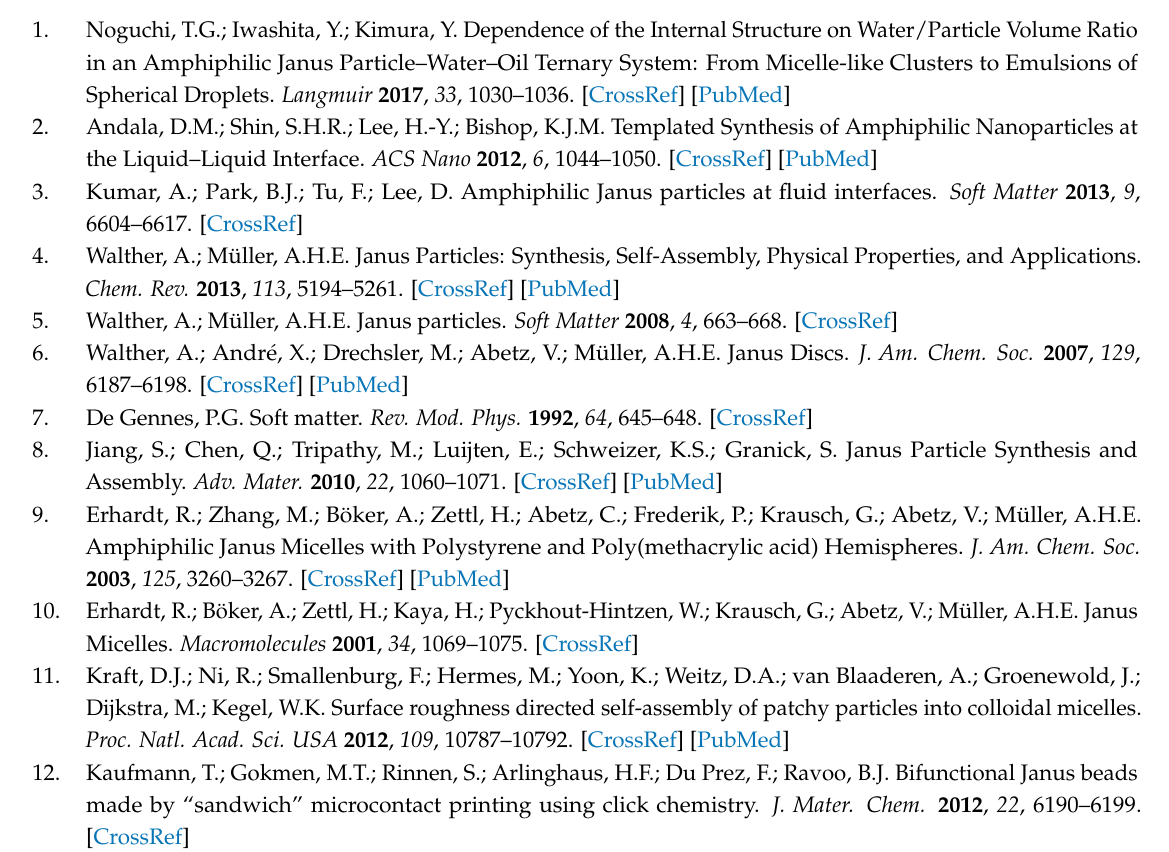
Figure S1: Fluorescent intensity of the fluorescent-labeled PMSQ particles vs. the number of rinsing cycles. Figure S2: The obtained diameters of the PC/PMSQ microspheres vs. the (a) surfactant concentration, (b) sonication amplitude percentage, and ( c ) sonication time. Figure S3: SEM micrographs of PC/PMSQ microspheres which were prepared at different PC concentrations, (a) 1 wt %, (b) 3 wt %, (c) 5 wt %, (d) 7 wt %, and (e) 10 wt %. Figure S4: Plan view SEM micrographs of PC/PMSQ precipitates in the absence of DDAB. Figure S5: The Intensity of the florescent signal of 6-aminofluorescein as function of its